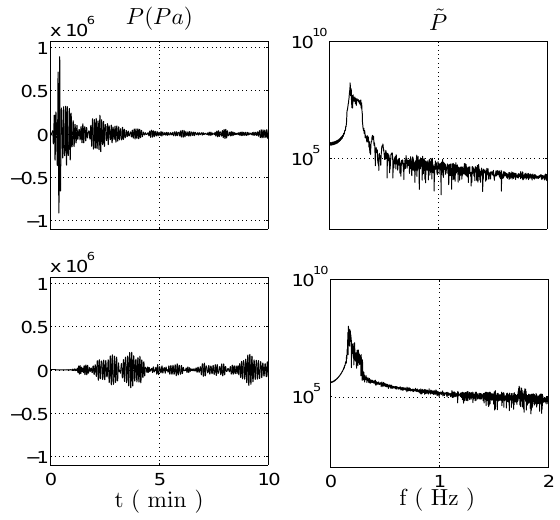
Figure 11. Pressure time series (left column) and their frequency spectra (right column) at Catania point (upper plots) and at Capo Passero point (lower plots), resulting from the numerical solution of the depth-integrated Eq (5) over the whole